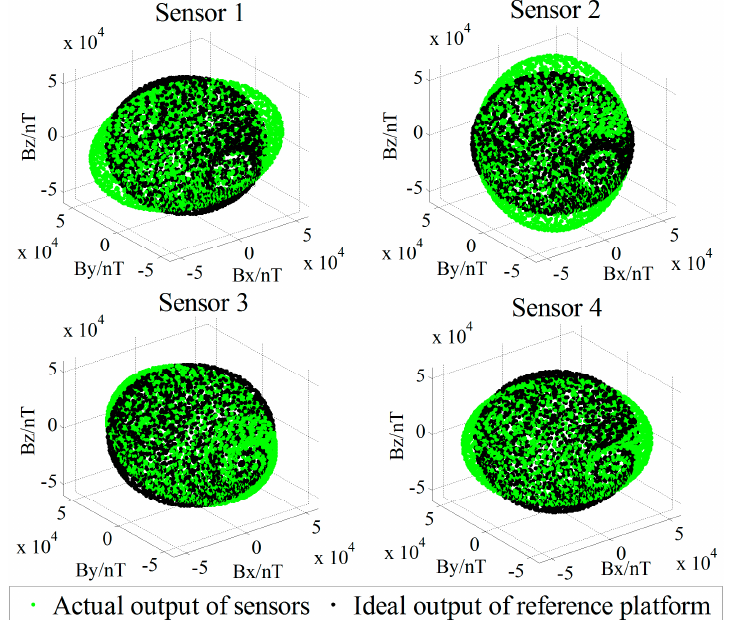
Figure 4. Spatial distributions of the tricomponent output in full spatial direction postures.